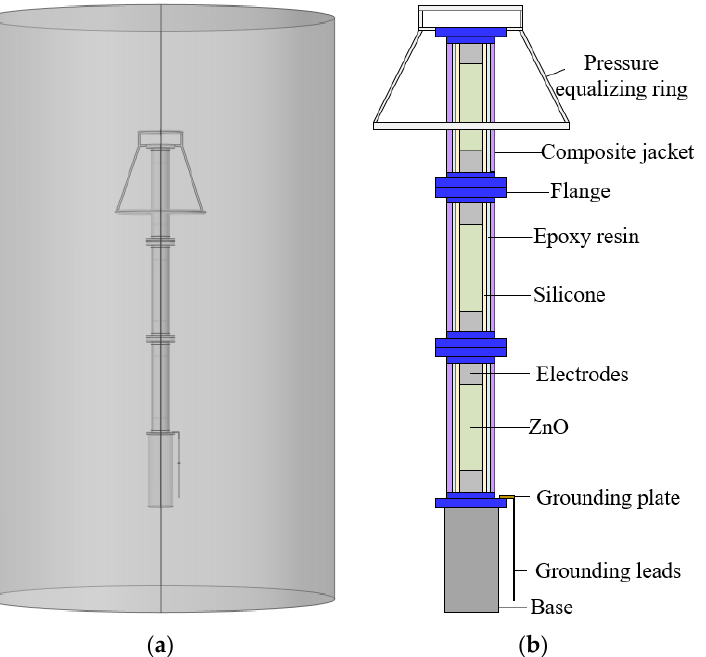
Figure 4. The structure of the 500 kV ZnO arrester. ( a ) an overall diagram of the 3D model; ( b ) the structural composition of the arrester.